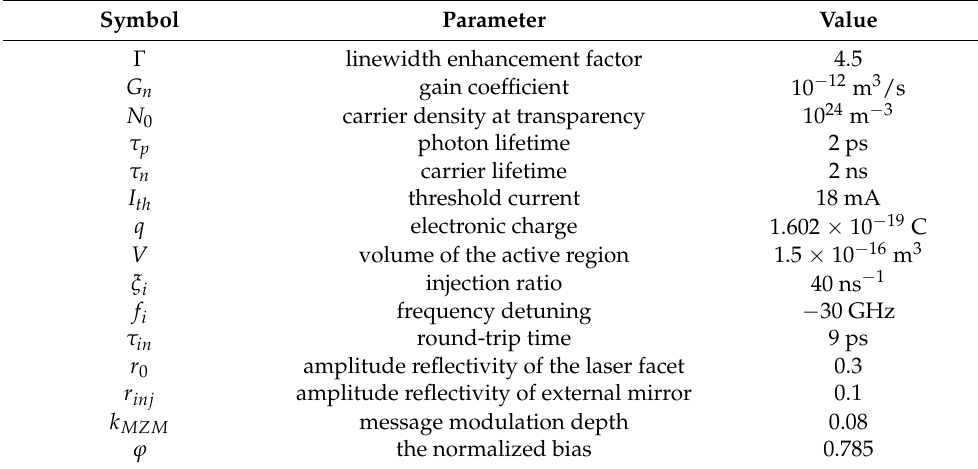
Table 1. Parameter values used in the numerical